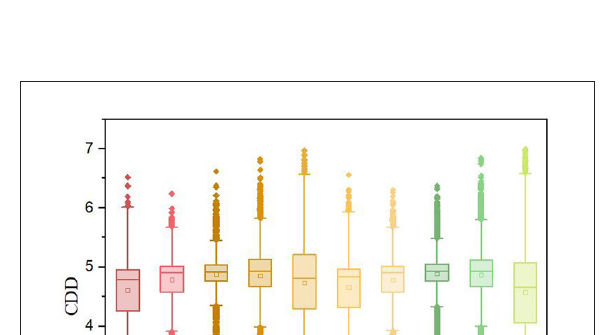
FIGURE4 Distribution of LST in LCZ (LST unit: ◦ C). LST, land surface temperature. LCZ, local climate zone. The results are sampled and counted according to the calculation results associated with the LCZ grids.